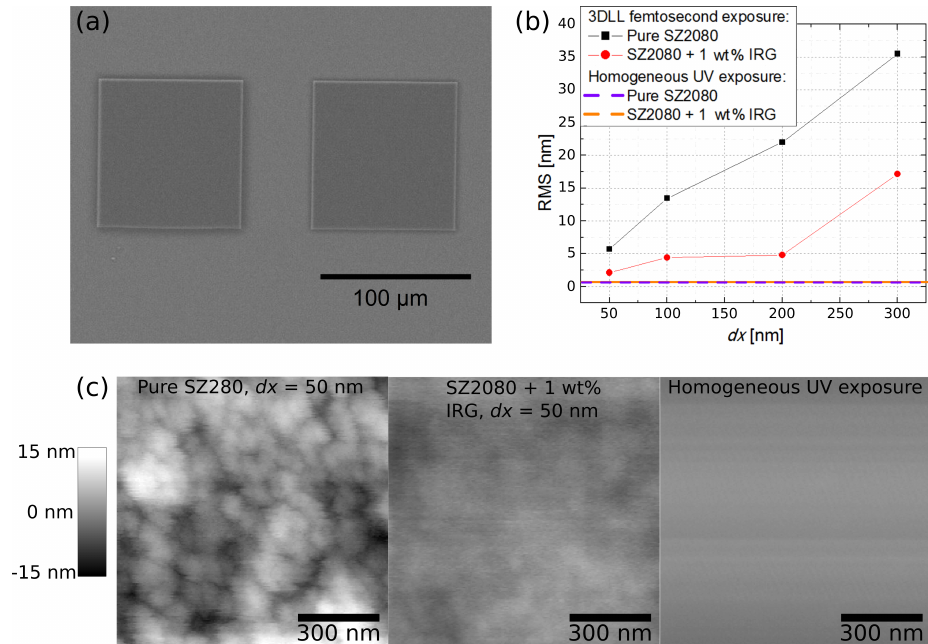
Figure 4. ( a ) SEM micrograph of the measured square polymerized structures; ( b ) RMS calculated for surfaces fabricated with different dx for SZ2080 containing PI and without it; and ( c ) AFM images of surfaces of pure and photosensitized polymer obtained with highest voxel overlap ( dx = 50 nm) as well as one which was produced via homogeneous UV